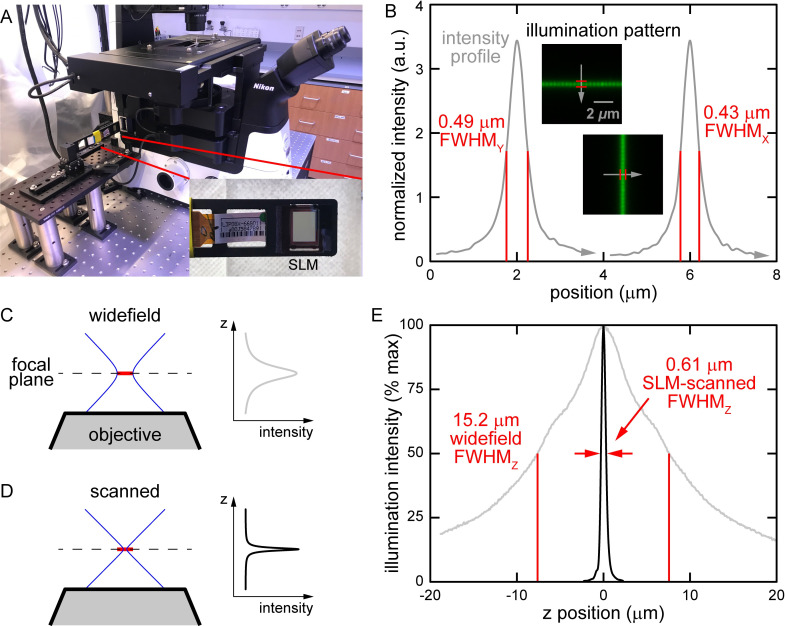
Illumination setup and resolution.(A) SLM on 3D-printed mount on 6-axis fine-positioning stage. SLM inserted into field stop of microscope. (B) Transverse illumination resolution determined using fluorescent dye thin film. (C) Approximate widefield axial illumination beam and intensity profiles. Illumination spans FOV (red). (D) Approximate scanned axial illumination beam and intensity profiles. Beam is scanned across FOV (red line). (E) Measured intensity along optical axis for widefield and SLM-scanned illumination beams. SLM-scanned illumination (black) has significantly better resolution than widefield illumination (gray).